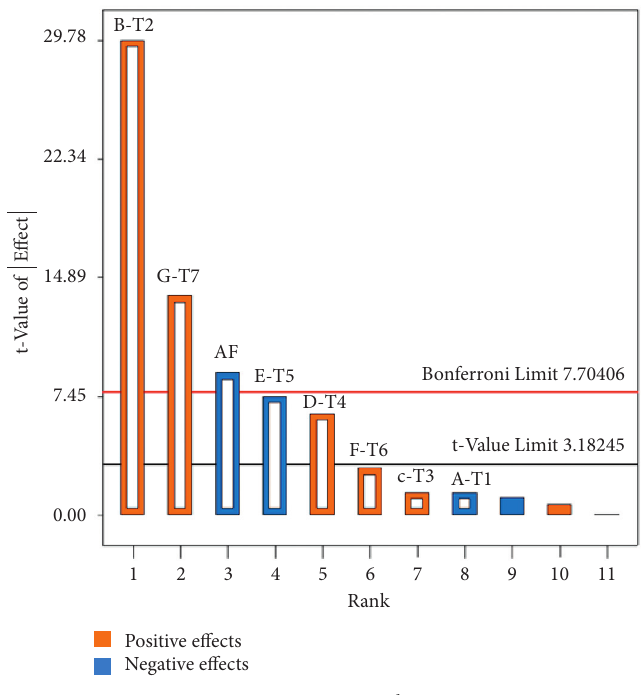
Figure 10: Pareto chart.